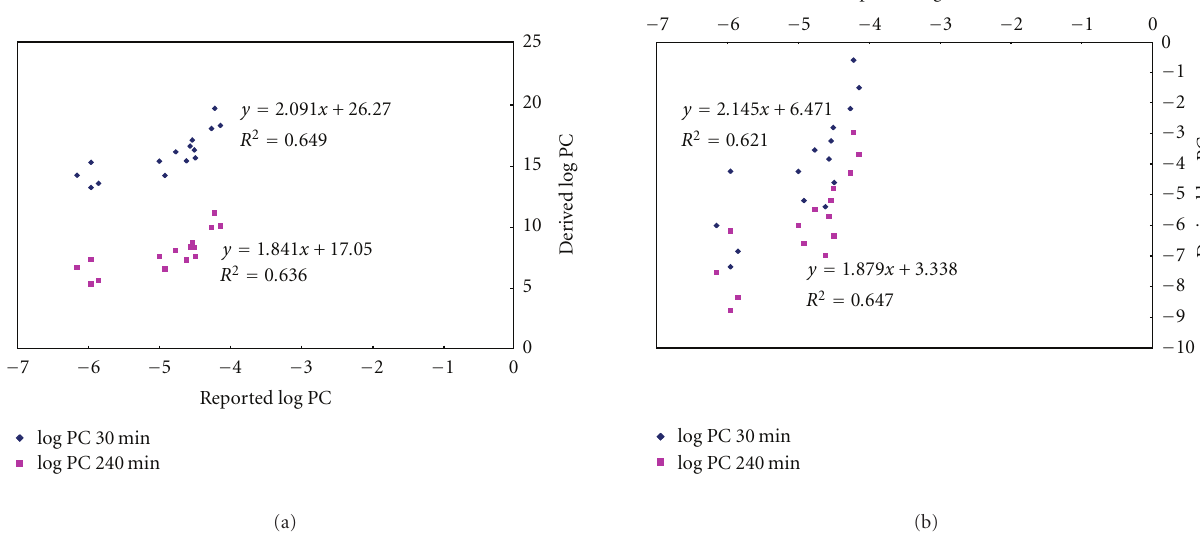
Figure 5: (a) Correlation between permeability coe ffi cient (logPC) reported in literature for β -blockers versus permeability coe ffi cient (logPC) derived values using newly developed algorithms (4) and (5) for β -blockers ( n = 15). (b) Correlation between the permeability coe ffi cient (logPC) reported in the literature for β -blockers versus permeability coe ffi cient (logPC) derived values from newly developed algorithms (6) and (7) for β -blockers ( n =